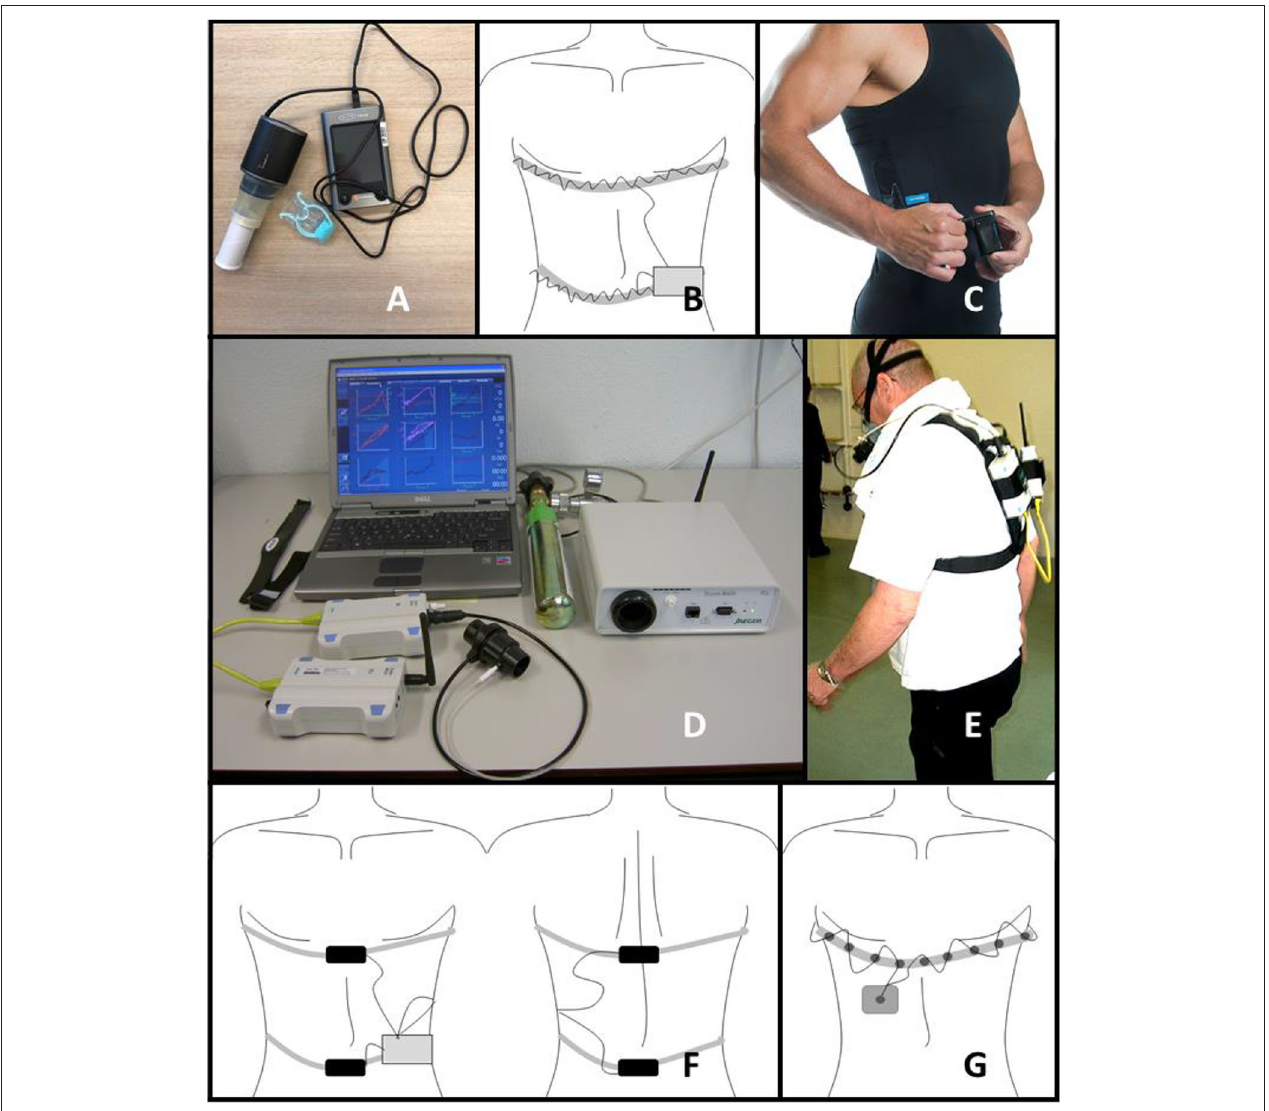
FIGURE 2 | Representation of techniques. (A) hand-hold spirometer, (B) schematic overview of RIP system (C) RIP incorporated in smart shirt (Hexoskin) (28), (D) portable BbB-analyser system, (E) portable BbB-analyser system worn by a patient (written informed consent was obtained from the individual for the publication of this figure), (F) schematic overview of RMP system, (G) schematic overview of EIT